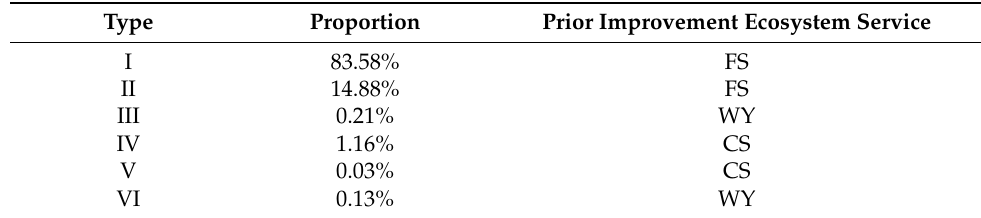
Figure 12. Spatial distribution of combination types of dominant ecosystem service in the synergies in I-I-I in 2015. Table 6. Improvement priority in I-I-I in